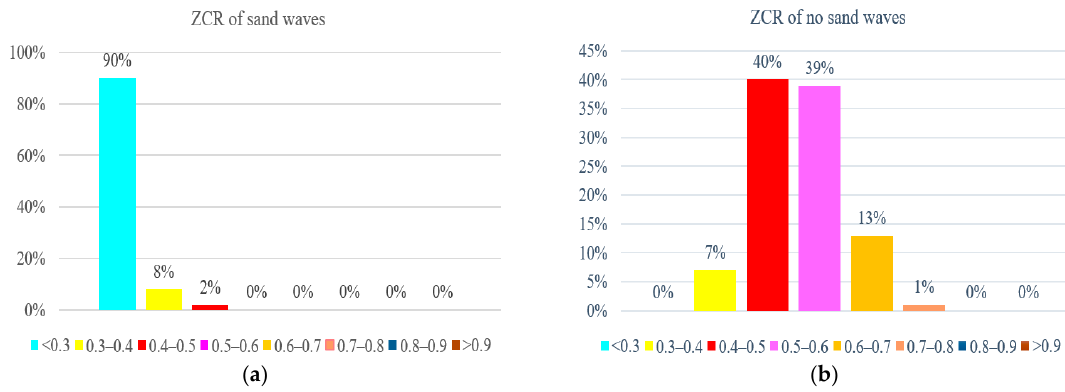
Figure 18. ZCR statistics. ( a ) With sand waves. ( b ) Without sand